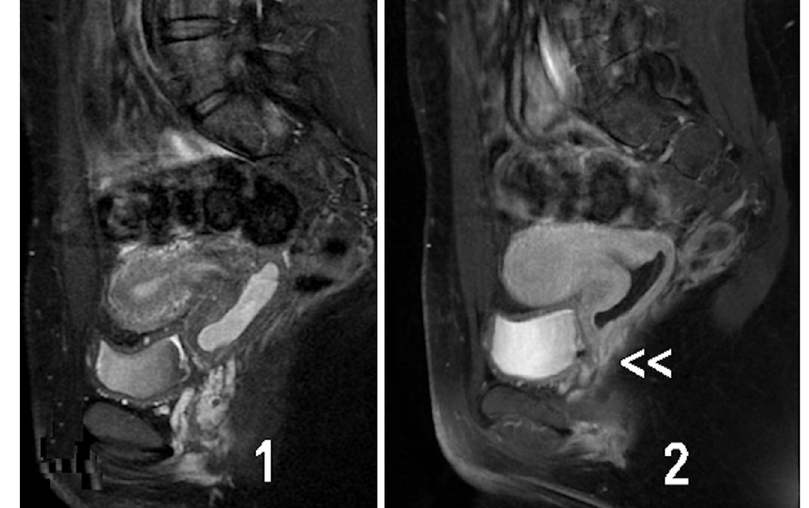
Fig. 9 Urogenital sinus anomalies. MR images [(1) T1- and (2) T2- weighted fat-supressed MR in the sagittal plane] showing a retrovesical blind vagina with apparent inferior half atresia and undetected fistula tract to the bladder (<<) in a 28-year-old patient. Cystoscopy confirmed the presence of an orifice situated in the trigone, just above the bladder neck,